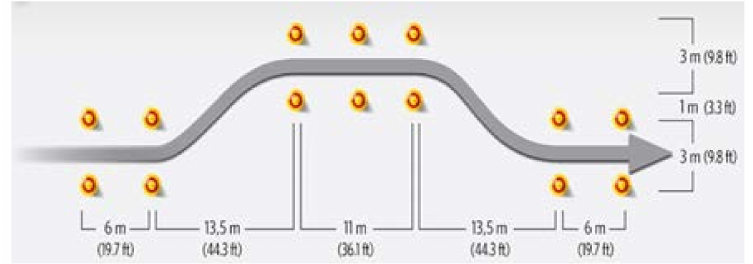
Figure 10. ISO 3888-2 (“modified”) Moose Test